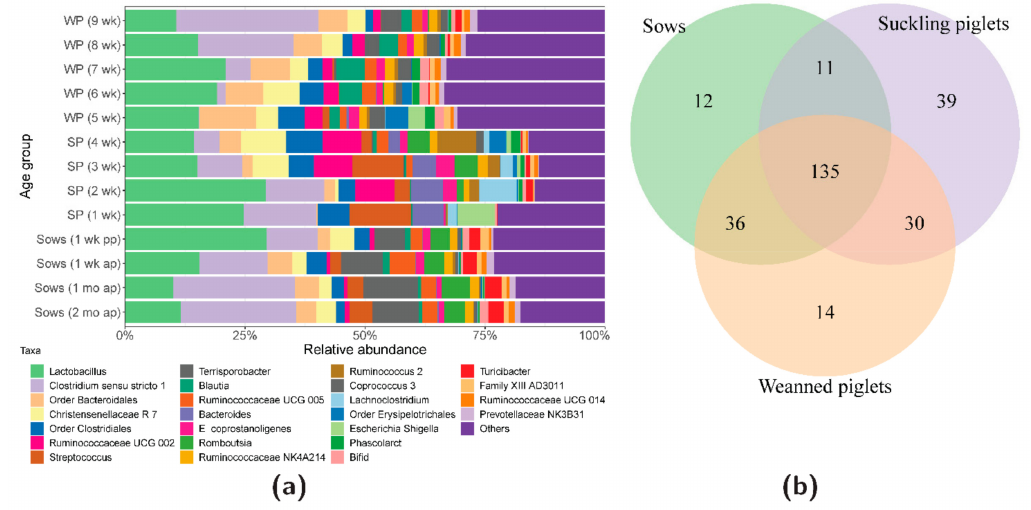
Figure 1. ( a ) Stacked bar plots showing the average percentage of bacterial taxa in sow and o ff spring faeces over time, ( b ) and a Venn diagram depicting the number of bacterial taxa that were unique and shared between sows, suckling, and weaned piglets, as analysed by the 16S rDNA